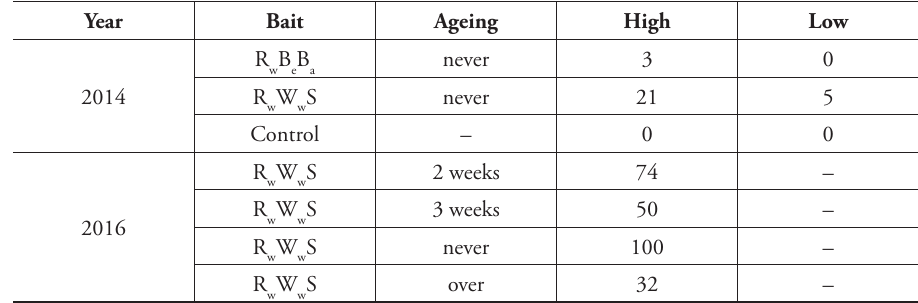
Table 3. Summary of captures data for Cerambyx cerdo recorded in 2014 and 2016 at Bosco della Fon- tana, using baited traps with different baits (R wine, sugar), different ageing (never = mixture never changed within comparison period; 2 weeks = mix- ture changed every 2 weeks, i.e. twice; 3 weeks = mixture changed every 3 weeks, i.e. once; over = mixture went over the comparison period), located at different heights (High = 10 m; Low = 1.5–2